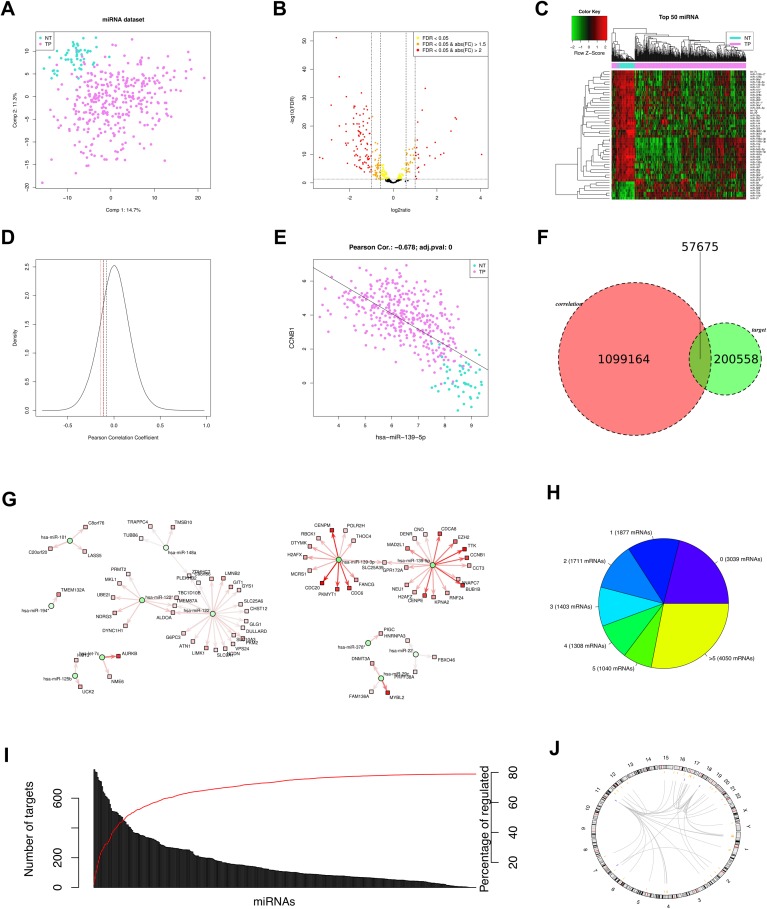
Main findings of the LIHC report.A) Principal Components Analysis (PCA) (based on correlation matrix) of miRNA samples. B) Volcano plot showing the miRNAs according to its logratio between cancer and control. C) Heatmap of the top 50 most deregulated miRNAs according to its FDR. D) Density plot of the Pearson Correlation Coefficients of all possible miRNA-mRNA interactions. Lines show different cutoff: p-value < 0.05, p-value < 0.01, FDR < 0.05 and FDR < 0.01. E) Correlation of miR-139-5p and CCNB1 as an example. F) Venn diagram showing the total number of sigifnicant correlations (FDR < 0.05), the total number of predicted interactions in at least one database (TargetScan or microcosm), and the intersection of both. G) Network of selected interactions. Each miRNA-mRNA interaction is negatively correlated (FDR < 10–33) and predicted at least in one database (Targetscan or MicroCosm). Circles represent miRNAs and squares mRNAs; red fill means upregulated miRNA/mRNA, while green fill means downregulated miRNA/mRNA; lines indicate the miRNA-mRNA pairs; red line means positive score and green line means negative score; arrow width is proportional to the number of appearances on the databases (TargetScan or MicroCosm). H) Pie chart showing the number of mRNAs regulated by 0, 1, 2, 3, 4, 5, and >5 miRNAs. I) Barplot showing the number of targets per miRNA and the percentage of mRNAs that are cumulatively regulated by the miRNAs. J) Circos plot of the top 45 miRNA-mRNA interactions sorted by FDR, a line means a miRNA-mRNA pair. Blue lines are the position of the miRNAs and orange lines are the position of the mRNAs.